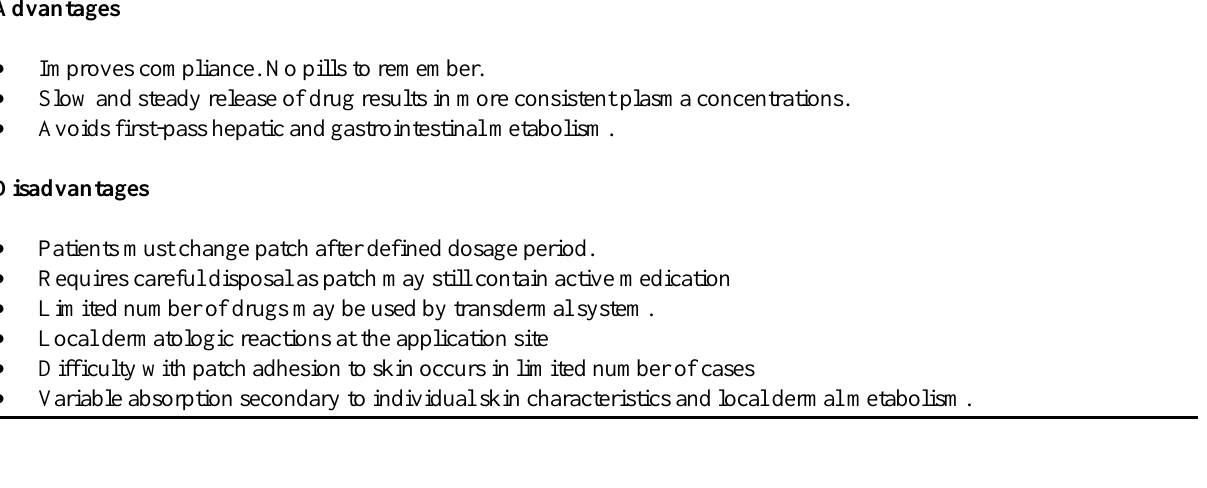
Table 1 – Transdermal drug delivery systems.